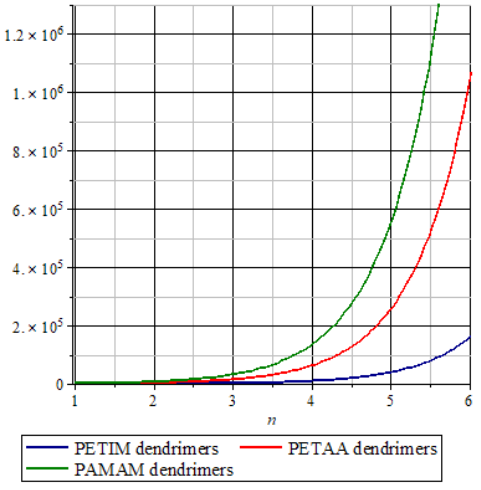
Figure 6. Total irregularity index.